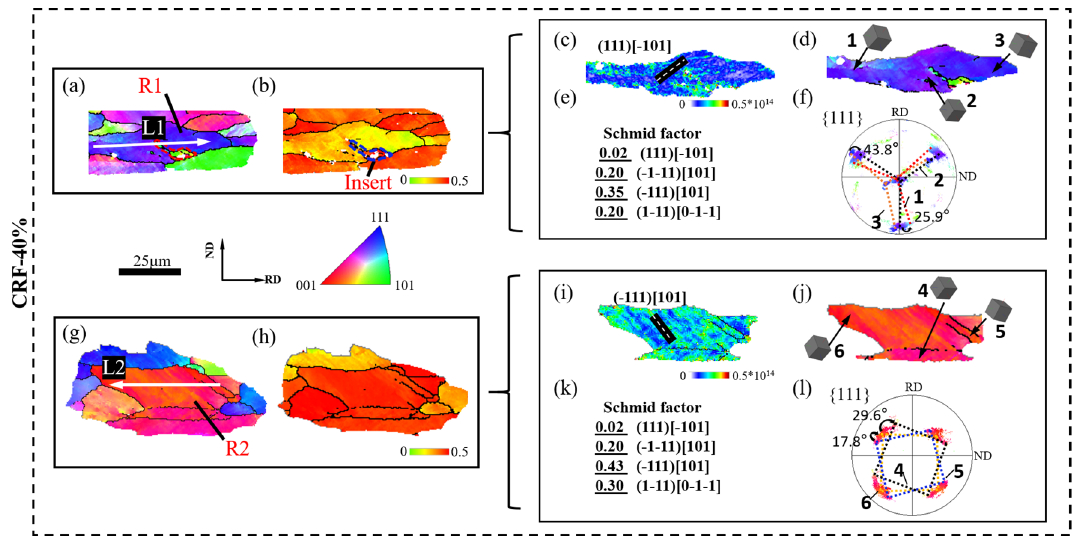
Figure 10. EBSD analysis of local area under CRF-40% conditions: ( a ) IPF map of large SF grains, ( b ) SF map of large SF grains, ( c ) GND map of large SF grains, ( d ) grain orientation of large SF grains, ( e ) SF value of large SF grains, and ( f ) PFs of large SF grains; ( g ) IPF map of small SF grains, ( h ) SF map of small SF grains, ( i ) GND map of small SF grains, ( j ) grain orientation of small SF grains, ( k ) SF value of small SF grains, and ( l ) PF of small SF grains.